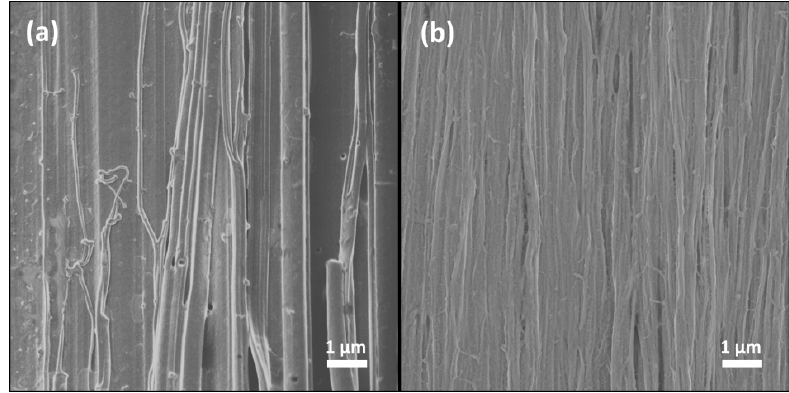
Figure 3. Scanning electron microscopy (SEM) images of ( a ) oriented ra-P3HT-TCB and ( b ) rg-P3HT-TCB films. Both samples show fiber structure in almost only one direction. The ra-P3HT-TCB film has fibers with the diameter from 100 nm to 500 nm. The rg-P3HT-TCB film shows a more uniform distribution of fibers with the diameter of 100–200 nm.